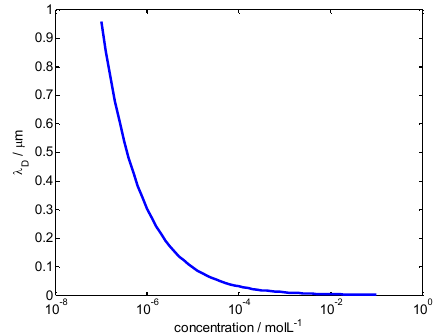
Fig.3: Debye screening length depending on the concentration of a 1:1 electrolyte. Note, the symbol (cid:79) D was chosen rather than (cid:78) as found in literature in order not to disturb with the conductivity where (cid:78) is used as